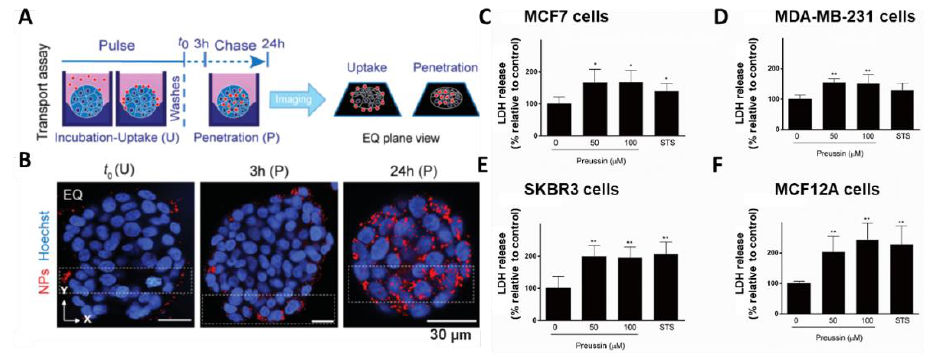
Figure 6. ( A ) Schematic illustration of transport assay for sensing NP drug uptake and penetration. ( B ) Confocal microscopic images showing spheroids at different stages of the NP uptake wave at Z- stacks. LDH cell viability assay for evaluating cytotoxic effect of preussin at different concentrations of 0 µ M, 50 µ M, 100 µ M, and STS (1 µ M) on ( C ) MCF7, ( D ) MDA-MB-231, ( E ) SKBR3, and ( F ) MCF-12A cells. (* p < 0.05; ** p < 0.01). Reprinted with permission from [117]. Copyright 2019, Wiley Online Library; Reprinted with permission from [119]. Copyright 2019, MDPI.